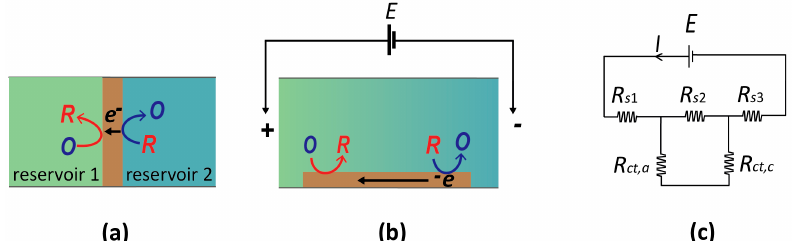
Figure 4. ( a ) Schematic diagram of a bipolar electrode (brown) in contact with two separate reservoirs. ( b ) Alternative concept of a bipolar electrode in which a uniform electric field is applied along a channel filled with electrolytic solution. A band electrode exposed to this solution exhibits bipolarity at its opposing ends (cathodic at left and anodic on right). ( c ) Equivalent circuit for panel (b). E is the potential applied across the solution, R s is the resistance of the solution, and R ct is the charge transfer resistance across the anodic/cathodic ends of the bipolar electrode (BPE).